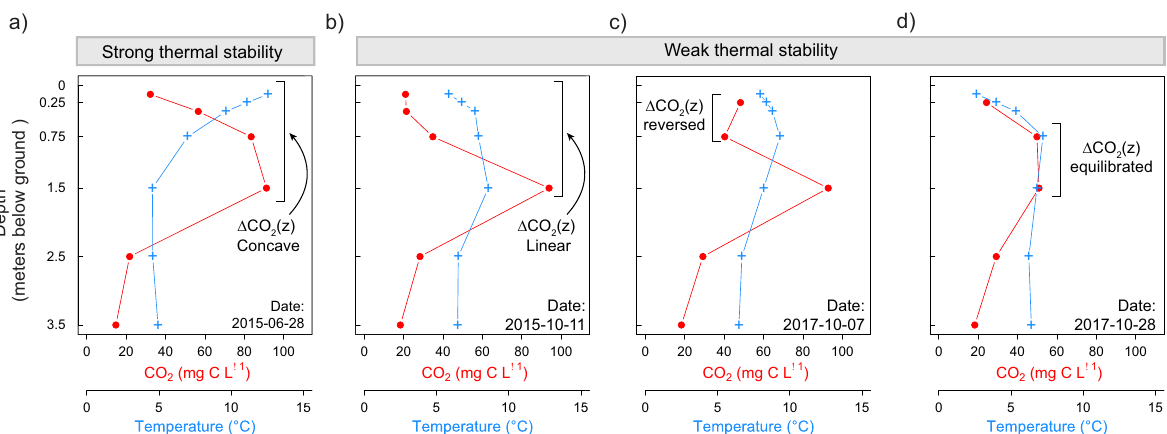
Fig. 3 Shapes of the peat porewater CO 2 concentration depth pro fi le. Depth pro fi le of the daily averaged porewater CO 2 concentration (red circles and lines) and temperatures (blue crosses and lines) from 0 to 3.5 m below ground surface. Each panel presents a different example of depth pro fi les: a during strong thermal stability, b weak thermal stability, where the CO 2 depth gradient ( Δ CO 2 ( z )) is linear, c weak thermal stability, where the Δ CO 2 ( z ) between 0.25 and 0.75 m is reversed, and d weak thermal stability, where the Δ CO 2 ( z ) between 0.75 and 1.5 m is in equilibrium (i.e. almost null).